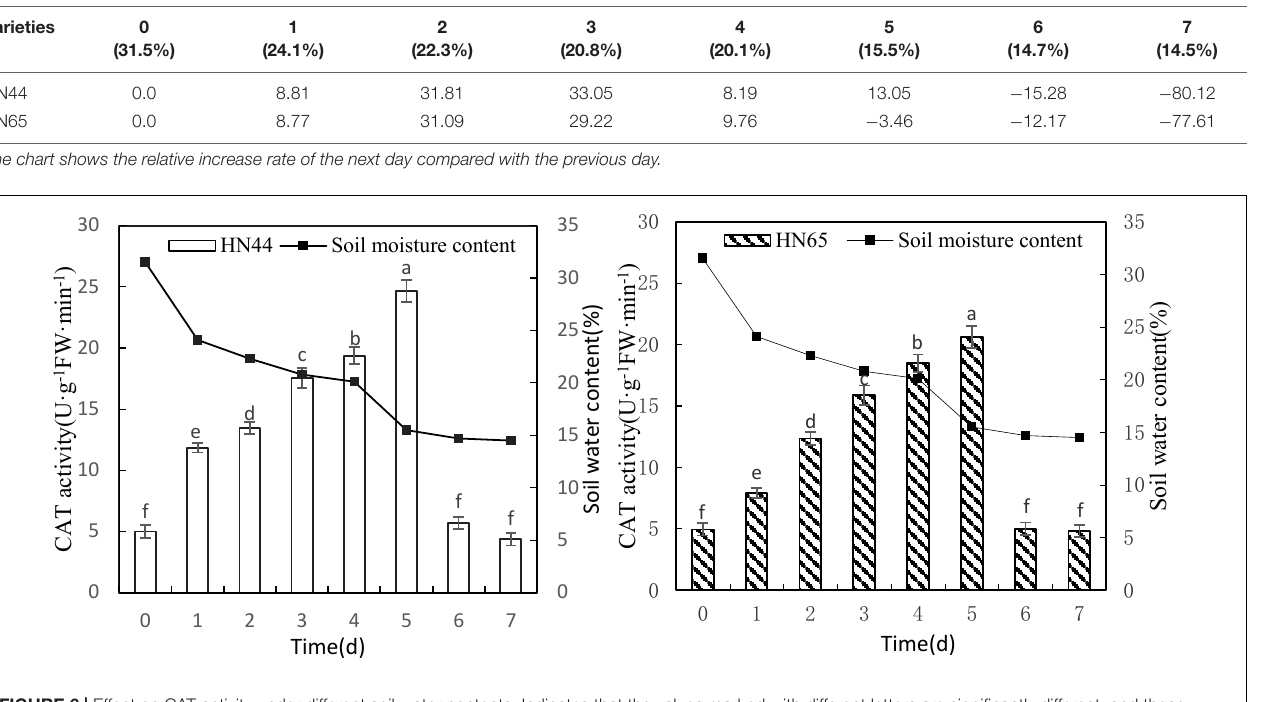
FIGURE 6 | Effect on CAT activity under different soil water contents. Indicates that the values marked with different letters are significantly different, and those marked with the same letter are considered to be statistically insignificant. TABLE 7 | Effect of drought on the relative growth rate of CAT activity